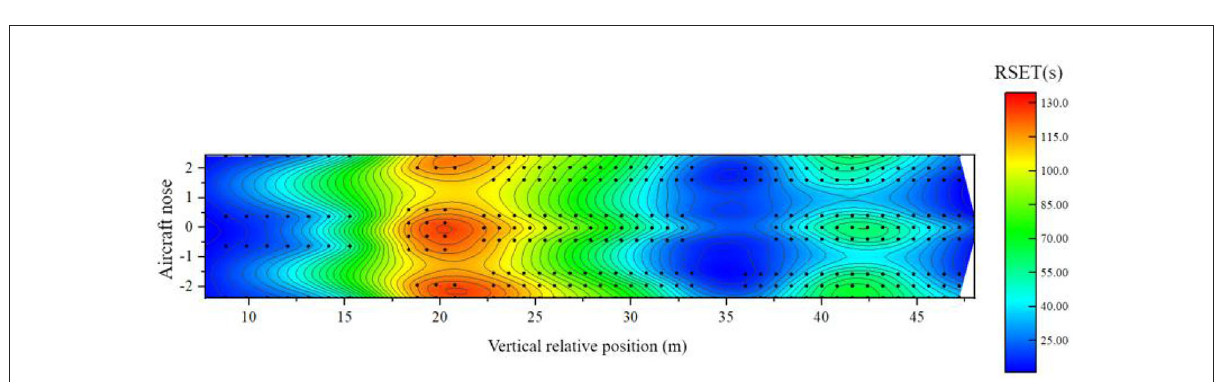
FIGURE18 Distribution of necessary evacuation time when the cabin is tilted forward.